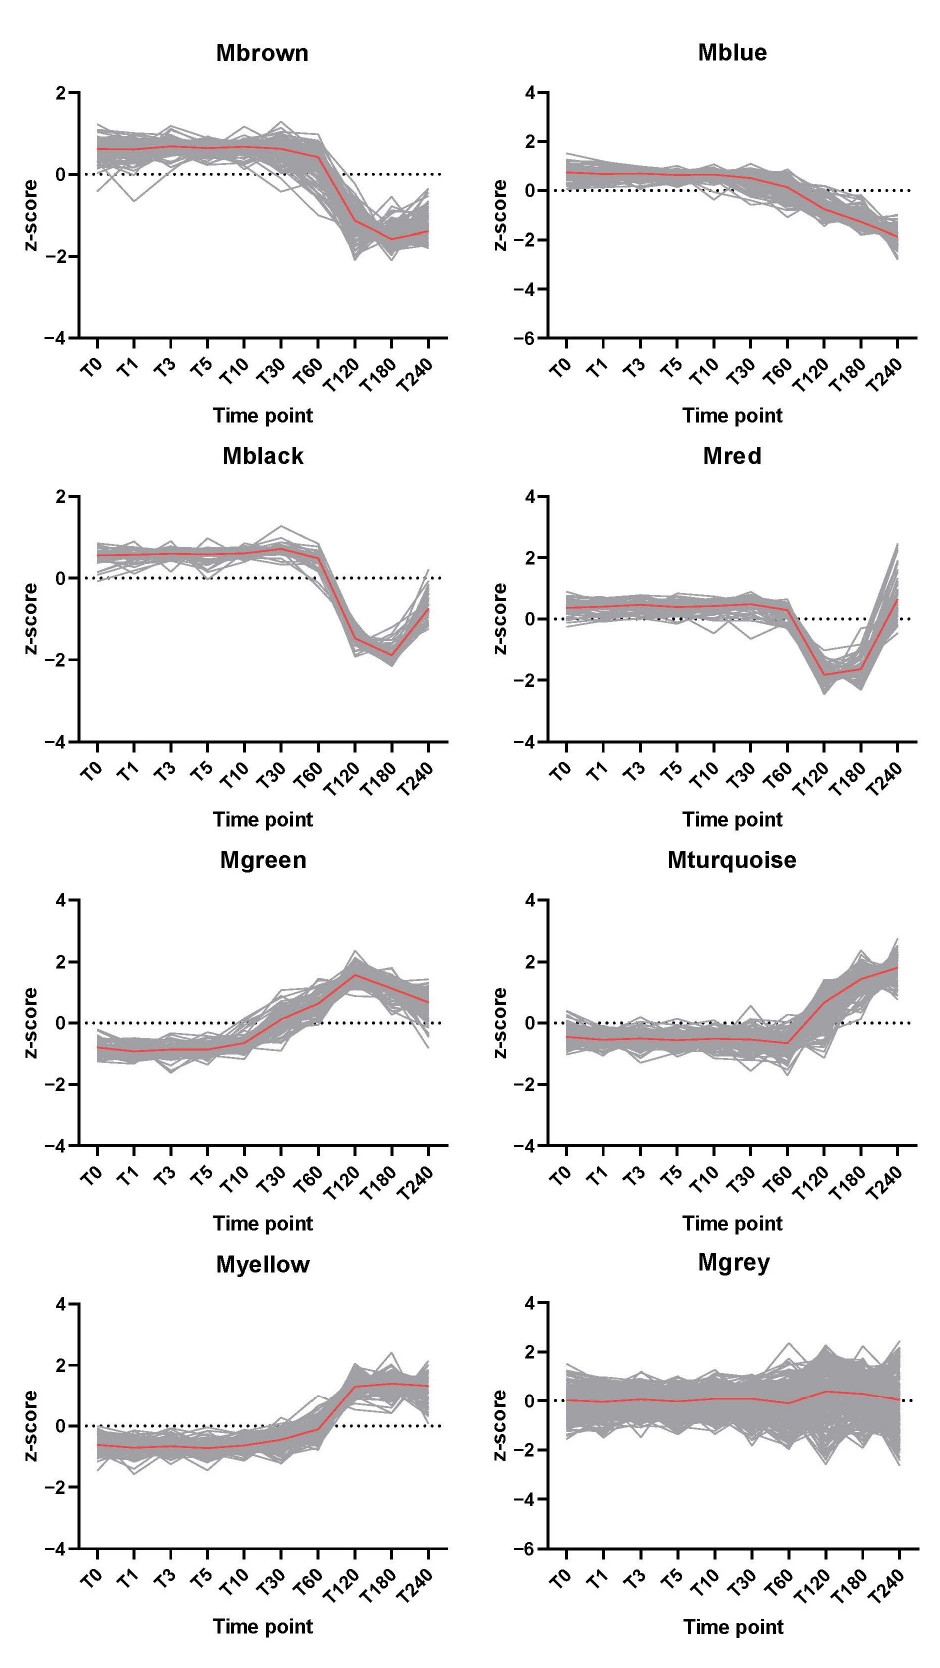
Figure 5. The trends in the z-score transformed protein levels of the modules across time points. The grey lines indicate protein level changes. The red lines represent the median z-scores for each mod- ule.